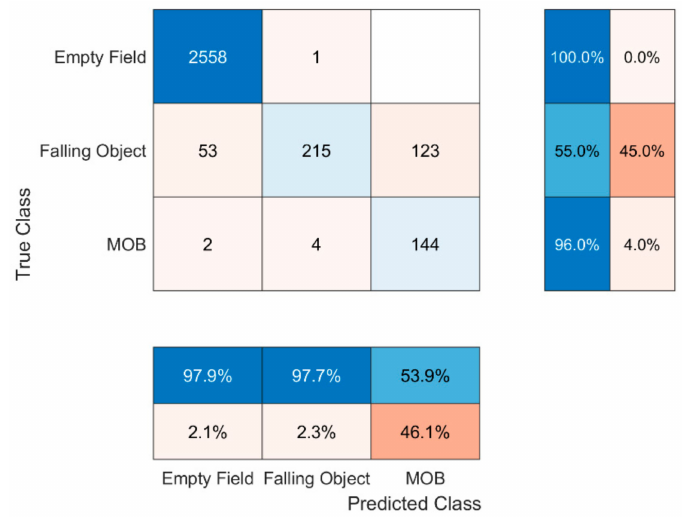
Figure 5. C2 (cid:48) s confusion